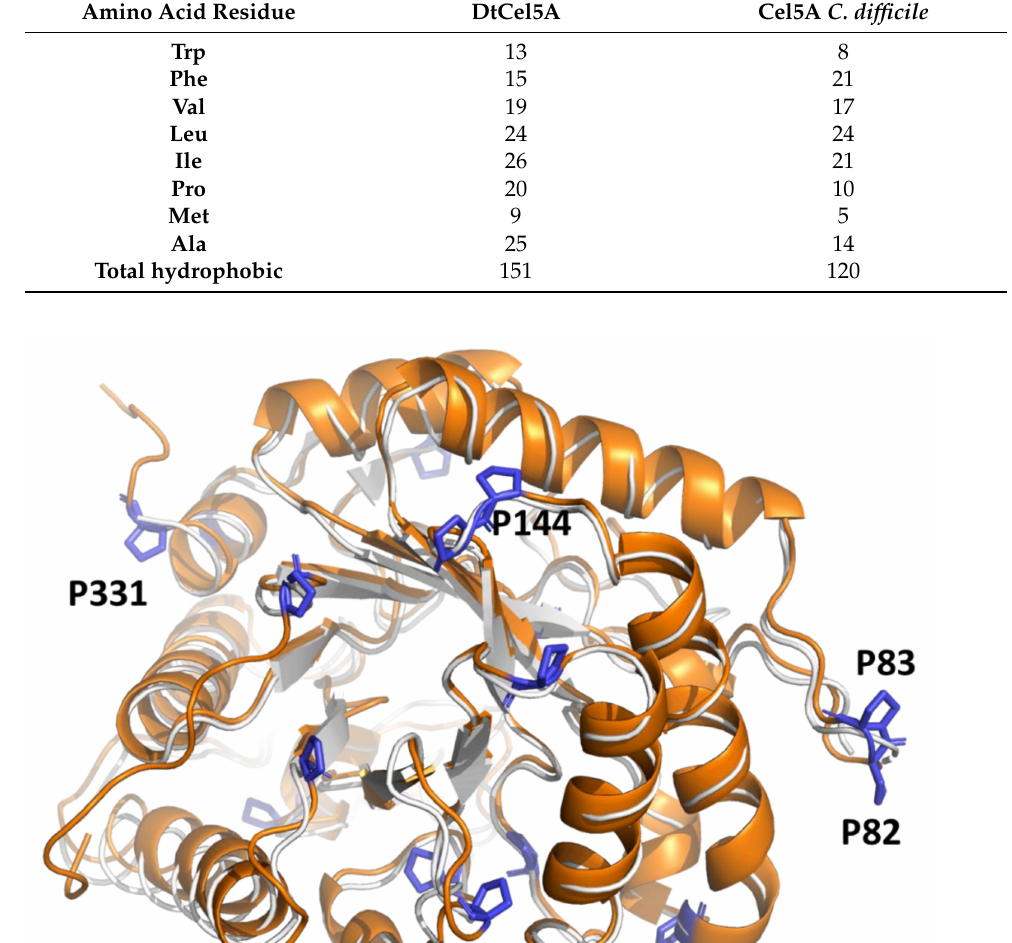
Table 2. Comparison between amino acid compositions of DtCel5A and the mesophilic Cel5A from C. difficile .